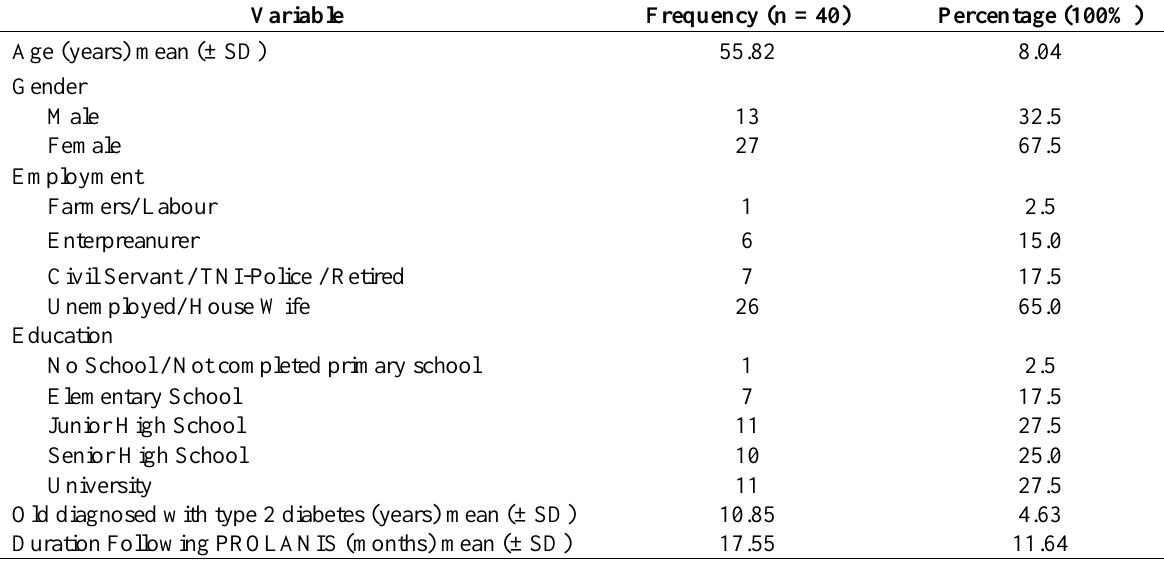
Table 1 Distribution of Individual Characteristics